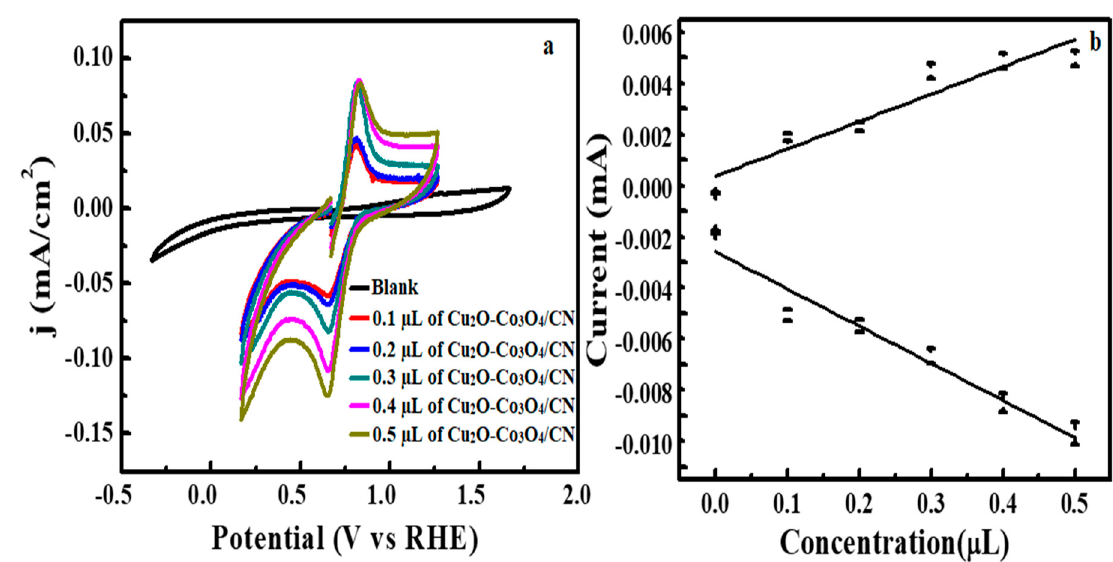
Figure 3. ( a ) CV curves of Cu 2 O-Co 3 O 4 /CN composite at slurry volume range from 0.1 to 0.5 µL in 1 M KOH; ( b ) linear calibration curve for oxidation and reduction at different concentrations.